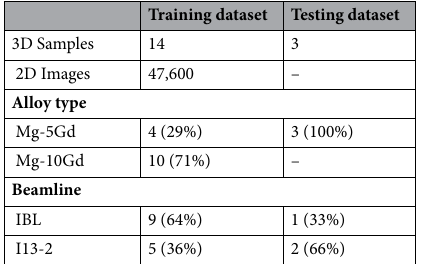
Table 1. Synchrotron radiation microtomography dataset characteristics. For training, each sample is sliced into 2D images based on the three main axes. For testing, the number of 2D images changes based on the multi-axes fusing